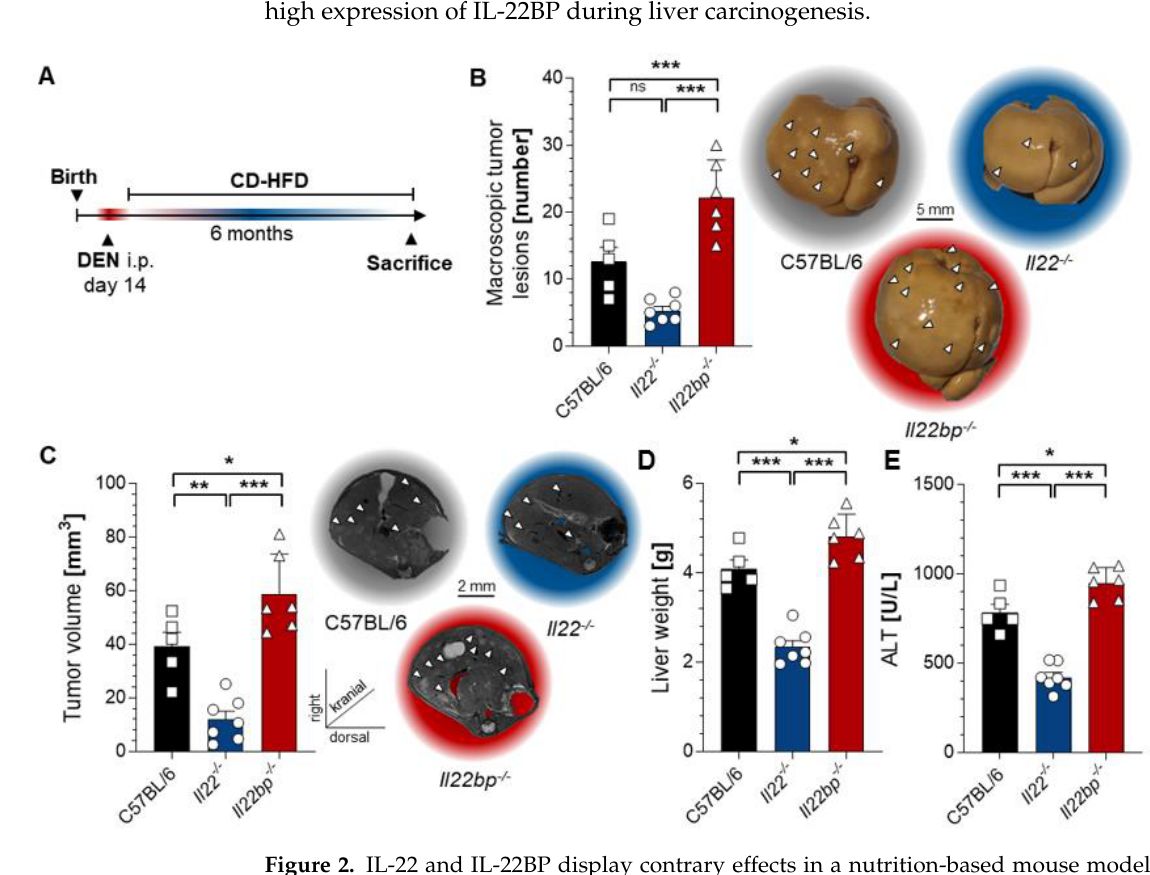
Figure 2. IL-22 and IL-22BP display contrary effects in a nutrition-based mouse model for HCC. ( A ) A schematic timeline describing the used nutrition-based HCC induction with CD-HFD in mice; ( B ) left: number of macroscopic tumor lesions in livers of 6 -month-old mice that were either wild type (C57BL/6, left, black, n = 5), Il22 -deficient ( Il22 -/- , middle, blue, n = 7) or Il22bp -deficient ( Il22bp -/- , right, red, n = 6); right: representative macroscopic pictures; ( C ) left: tumor volume (in mm 3 ) assessed by MRI in livers of month-old mice after CD-HFD feeding that were either wild type (C57BL/6, left, black, n = 5), Il22 -deficient ( Il22 -/- , middle, blue, n = 7) or Il22bp -deficient ( Il22bp -/- , right, red, n = 6); right: representative macroscopic pictures; ( D ) liver weight of 6 -month-old mice after CD-HFD feeding that were either wild type (C57BL/6, left, black), Il22 -deficient ( Il22 -/- , middle, blue) or Il22bp -deficient ( Il22bp -/- , right, red); ( E ) serum ALT levels (in U/l) of 6-month-old mice after CD-HFD feeding that were either wild type (C57BL/6, left, black), Il22 -deficient ( Il22 -/- , middle, blue) or Il22bp -deficient ( Il22bp -/- , right, red). Data are pooled from 2 independent experiments. Data presented as mean ± SEM. ns: p > 0.05; *: p < 0.05; **: p ≤ 0.01; ***: p ≤ 0.001 as assessed by Mann – Whitney U test.